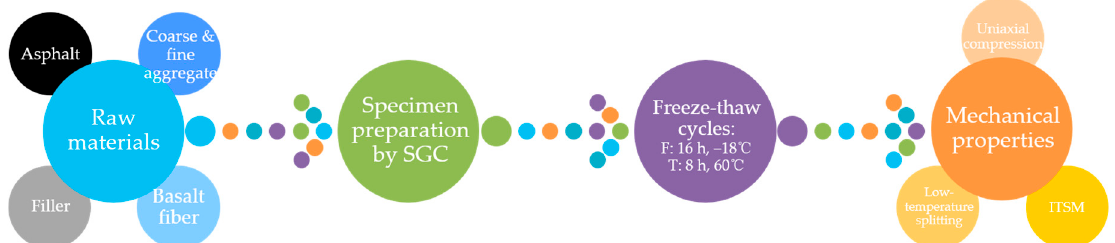
Figure 2. Flowchart of the experimental procedure used in this paper.